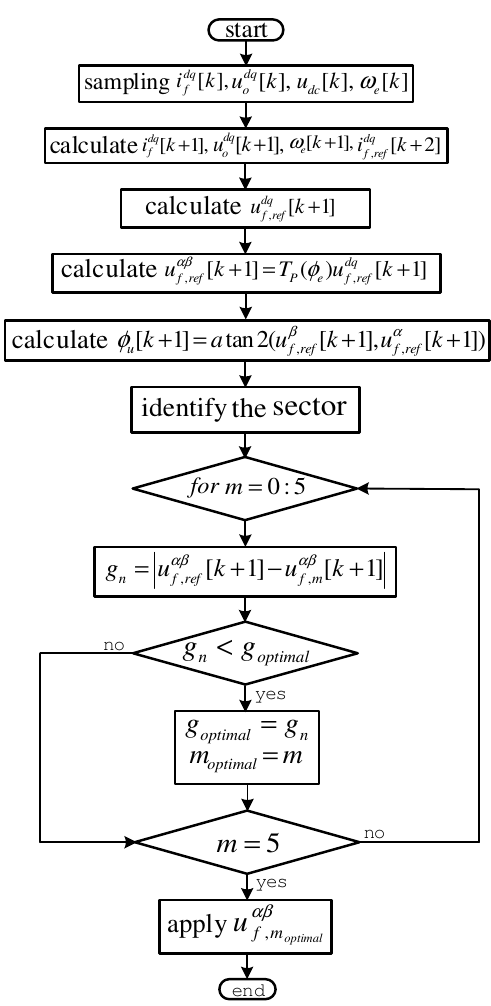
Figure 5. Flow-chart of the presented DMPC for power converters tied to the grid.